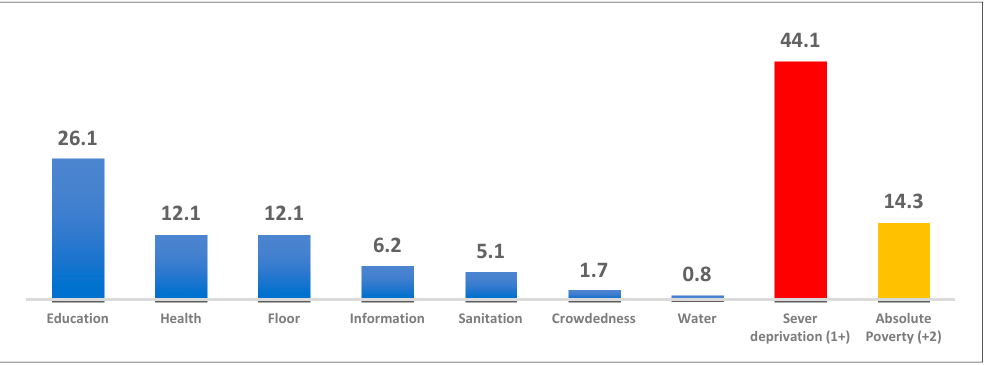
Figure 4. Prevalence of deprivations (%) among youth 18–29 years, 2014. Note: Authors, data from HCP open data (www.hcp.ma) (accessed on 1 April 2022).